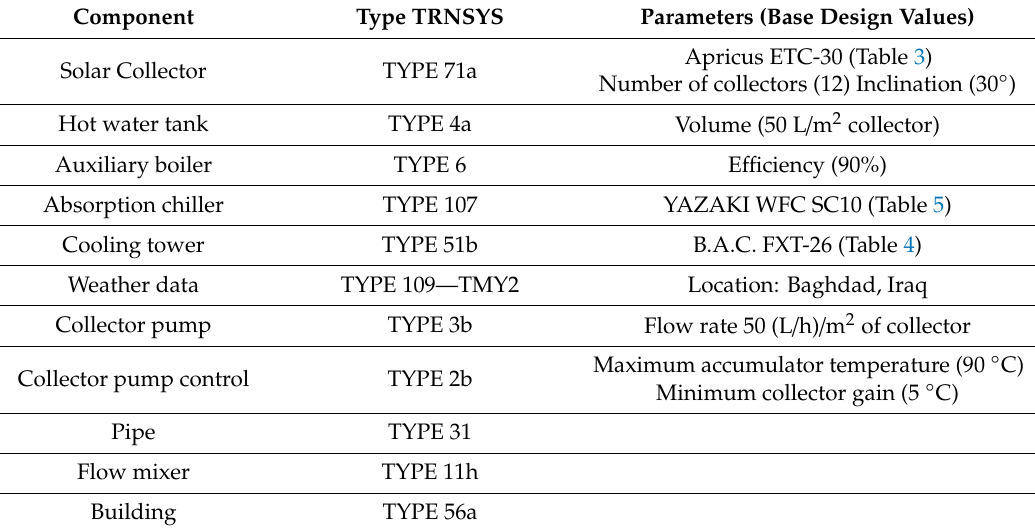
Table 4. List of the most important components of the TRNSYS